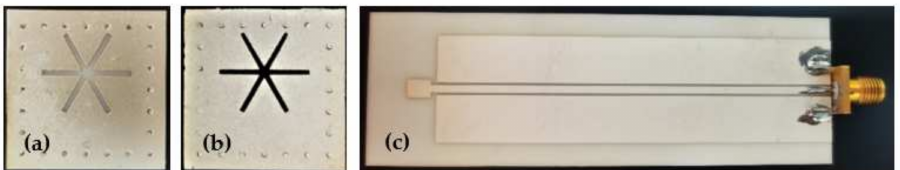
Figure 7. ( a ) Al 2 O 3 ceramic sensor, ( b ) SiC ceramic sensor, ( c ) the inquiry